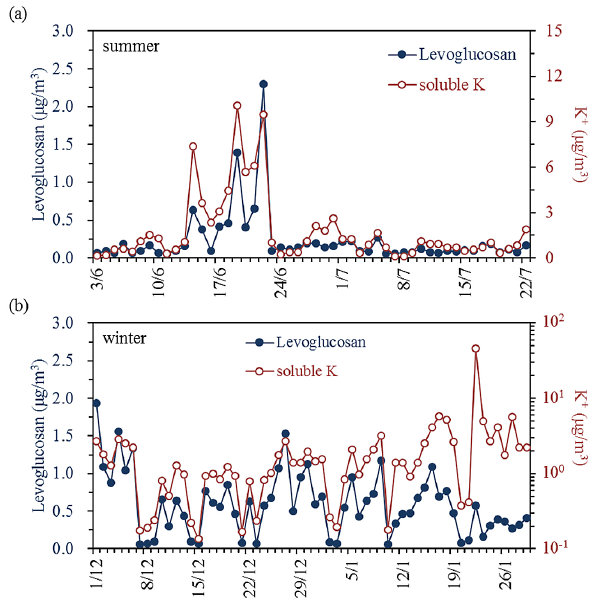
Fig. 2. Daily variation of levoglucosan and K + concentrations dur- ing summer (a) and winter (b) in Beijing.